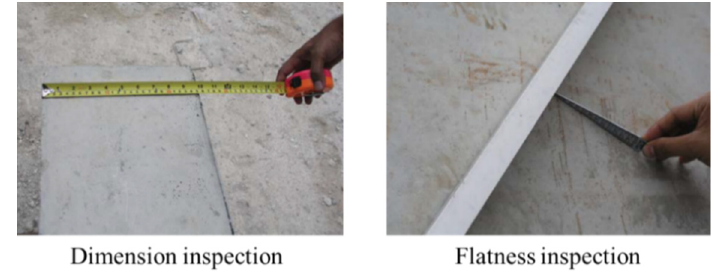
Figure 1. Manual geometric quality inspection of prefabricated components.